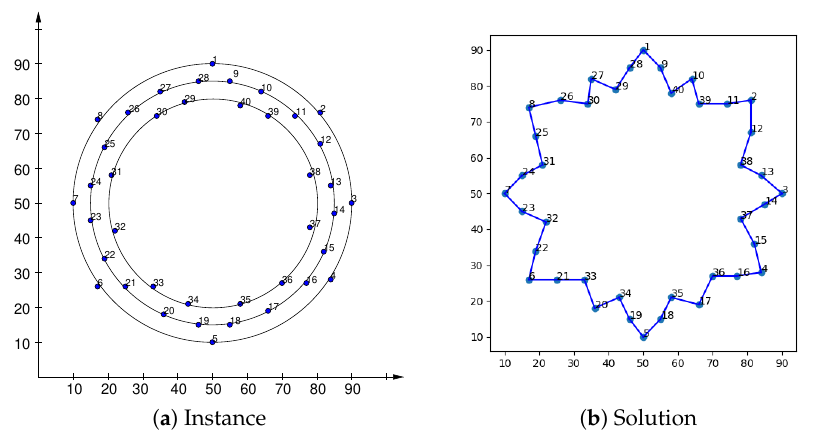
Figure 23. Instance “ FNV40.tsp ” and its solution.